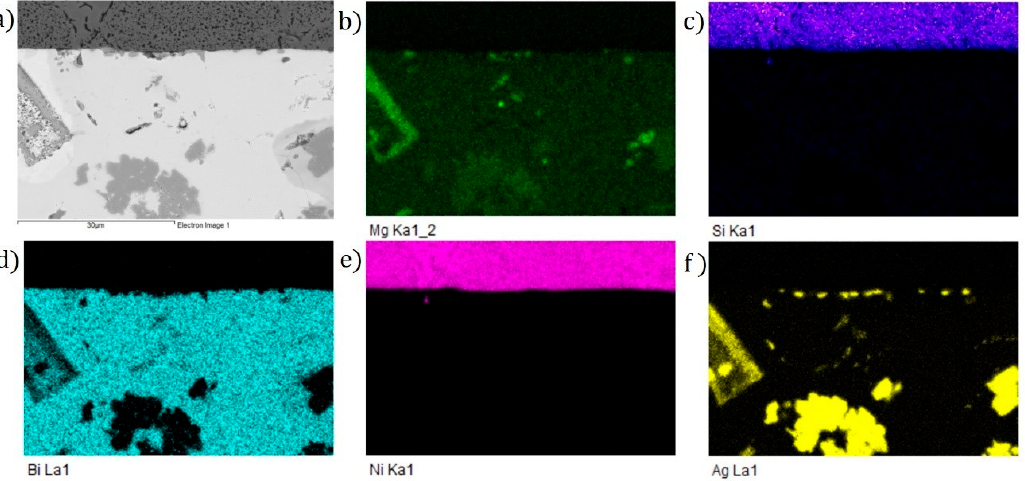
Figure 18. Planar distribution of elements at the boundary of the Bi11Ag1Mg/Ni–SiC joint: ( a ) joint microstructure; ( b ) Mg; ( c ) Si; ( d ) Bi; ( e ) Ni; and ( f )